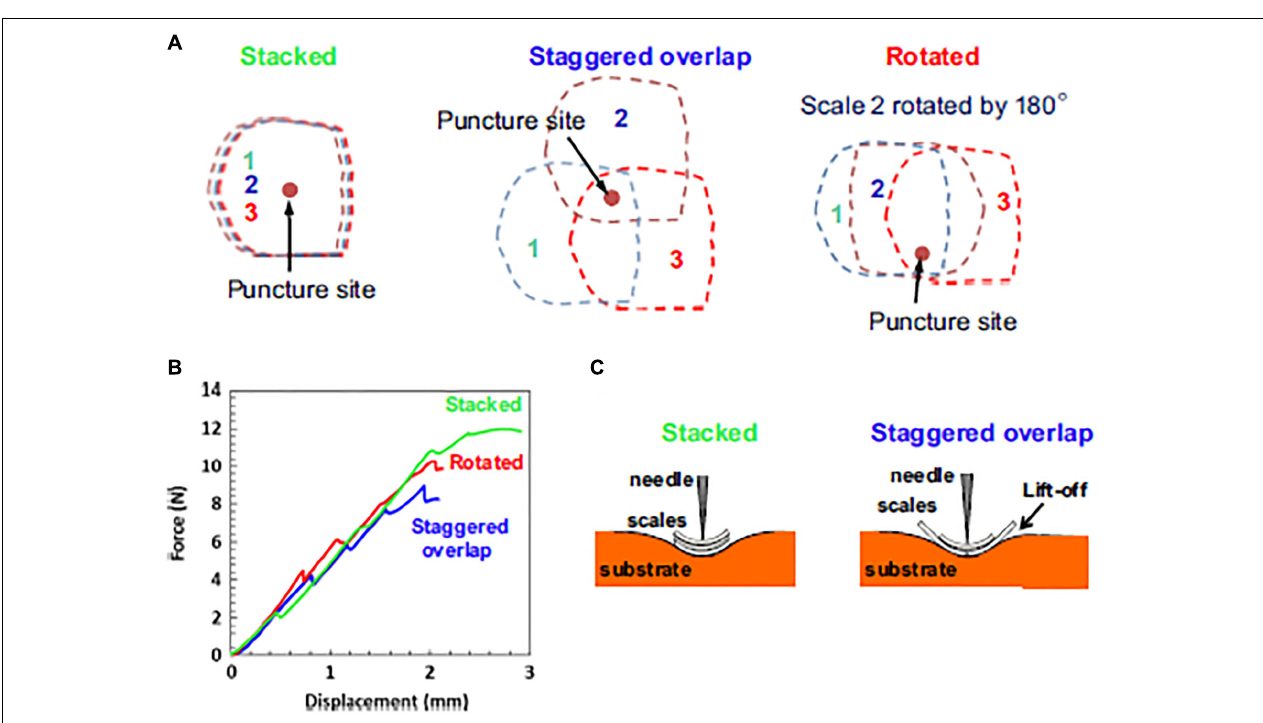
FIGURE 12 | (A) Scale arrangements used for tests: stacked, staggered (natural) overlap, and rotated, (B) force displacement curves for the three scale arrangements, and (C) “sink-in” mechanism of scale and substrate deformation (Zhu et al., 2013).